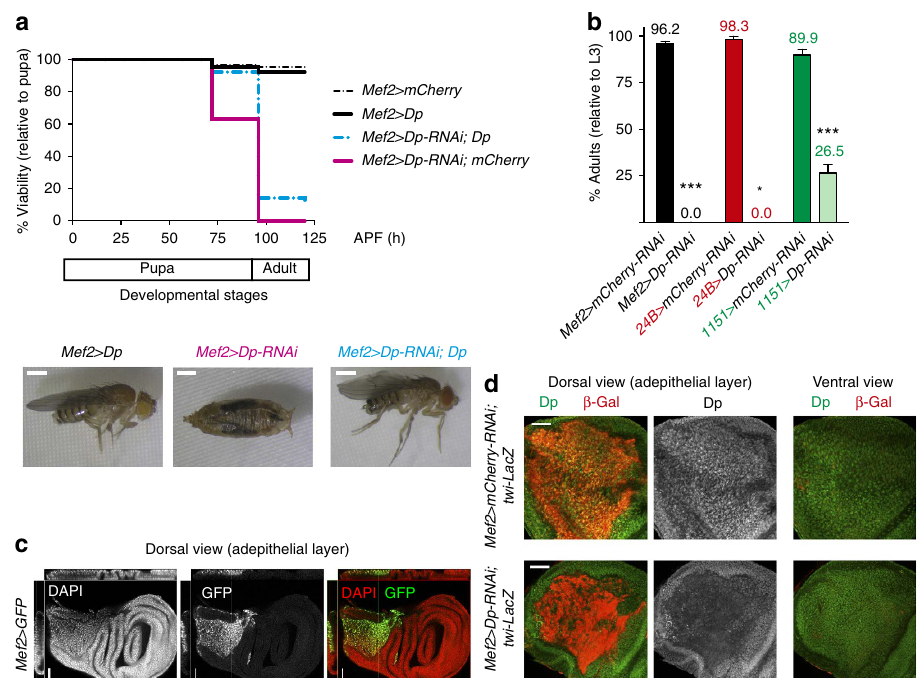
Figure 1 | Muscle-specific inactivation of Dp results in lethality. ( a ) The number of viable flies was quantified throughout pupa development. The pan- muscular Mef2-GAL4 driver was used to knockdown Dp by RNAi ( UAS-Dp-RNAi;Mef2-GAL4 , magenta line, n ¼ 654 flies). Re-expression of Dp partially rescues the lethality ( UAS-Dp-RNAi;Mef2-GAL4/UAS-Dp , cyan-coloured dotted line, n ¼ 536 flies). The matching control flies are Mef2-GAL4/UAS- mCherry-RNAi (dotted black line, n ¼ 417 flies) and Mef2-GAL4/UAS-Dp (solid black line, n ¼ 523 flies). Data from three independent experiments were plotted. Representative images of adults and pharate pupa are shown at the bottom. Scale bar, 0.5mm. ( b ) Lethality was quantified as the percentage of eclosed adults relative to the number of third instar larvae (L3). The GAL4 drivers Mef2-GAL4 (black bar, n ¼ 239 and 173 flies), 24B-GAL4 (red bar, n ¼ 64 and 71 flies) and 1151-GAL4 (green bar, n ¼ 159 and 158 flies) were crossed either to UAS-mCherry-RNAi or UAS-Dp-RNAi . Mean ± s.e.m. Data from at least two independent experiments were plotted, Mann–Whitney test. * P o 0.05; *** P o 0.001. ( c ) The expression of Mef2-GAL4 is restricted to the adepithelial cells of late third instar larval wing discs. Several confocal images were taken in a z-stack. Orthogonal confocal cross-sections are presented on the top and left side of each image. Scale bar, 100 m m. ( d ) Wing discs of late third instar larvae stained with anti-Dp antibody (green) and labelled with twi-lacZ marker ( b -Gal, red). Although Dp is localized in nuclei throughout the wing disc, Dp protein was specifically depleted only in the adult myoblast of UAS-Dp-RNAi;Mef2-GAL4 (bottom panel) compared with control Mef2-GAL4/UAS-mCherry-RNAi (top panel). Two different confocal planes of the discs are shown: the dorsal view, which contains the adepithelial layer (left panel), and the ventral view (right panel). The experiment was repeated twice. Scale bar, 50 m m.